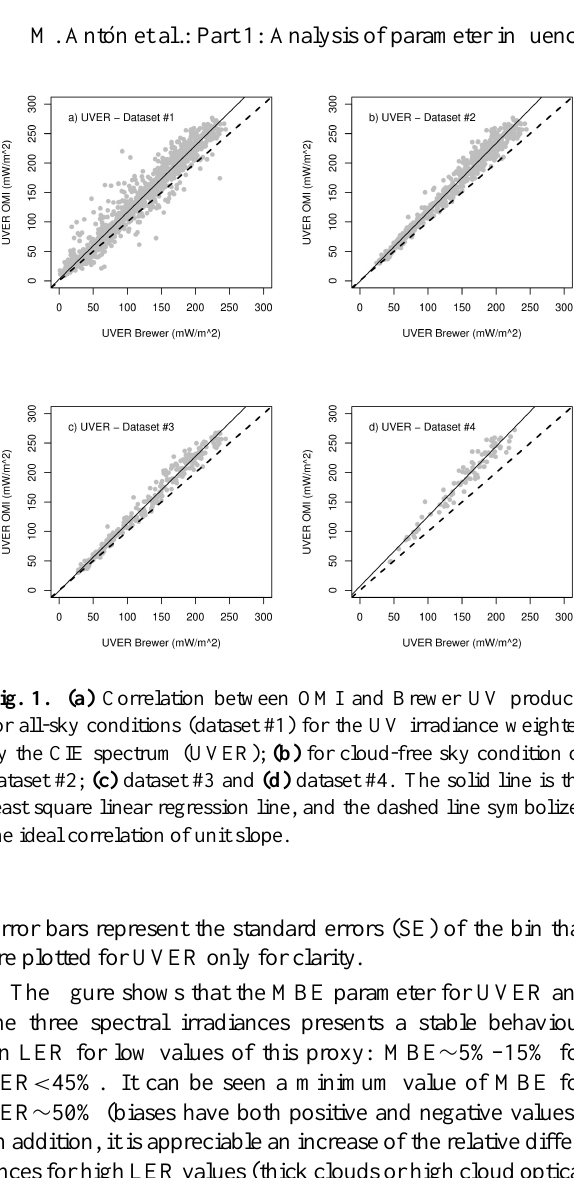
Error bars represent the standard errors (SE) of the bin that are plotted for UVER only for